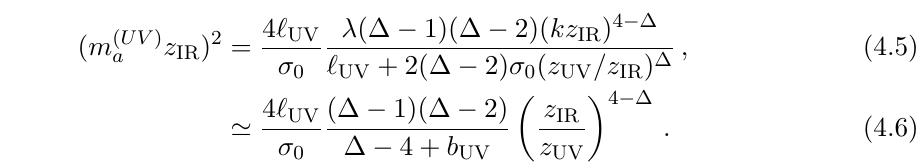
Figure 2 . Axion mass relative to the compositeness scale ( z (cid:0) 1 b UV = 0. The curves correspond to the analytic solution for g 5 = 0 (4.5), while the points are obtained by numerically solving the equations of motion with g 5